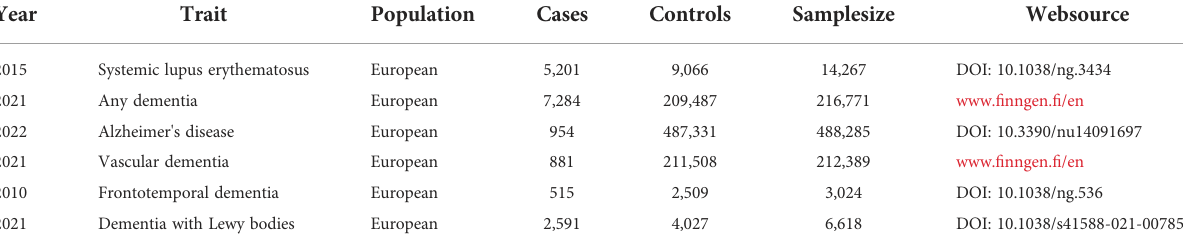
TABLE 1 Details of the GWAS included in the Mendelian randomization.